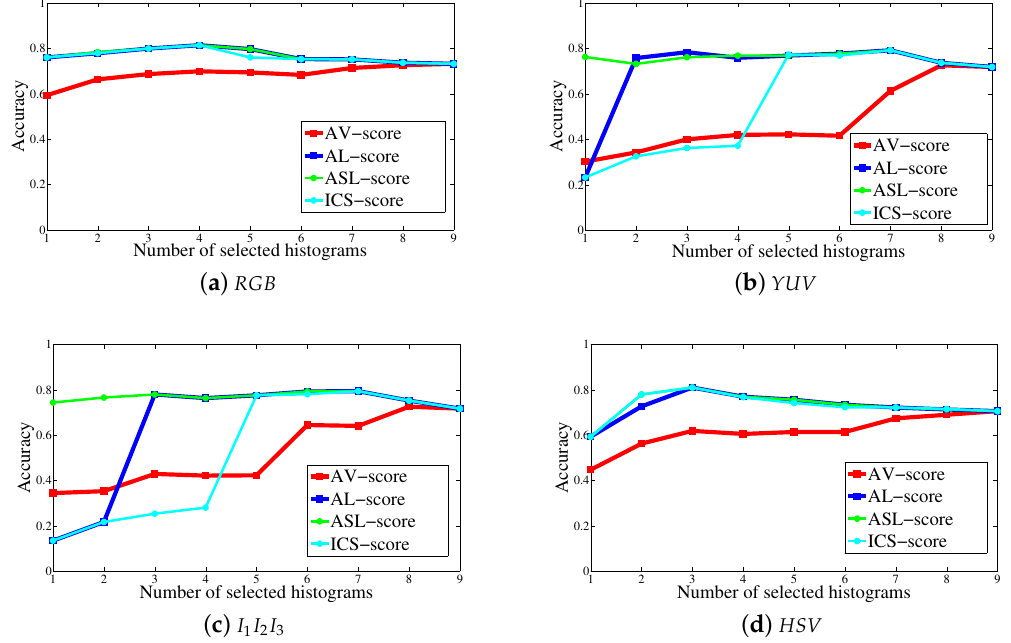
Figure 3. Classification accuracy R d according to the number d of ranked histograms on